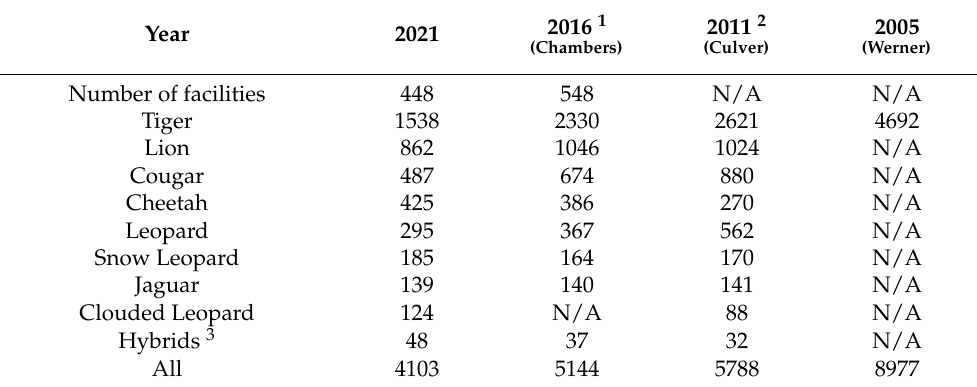
Table 2. Comparative species totals from this study and previous big cat